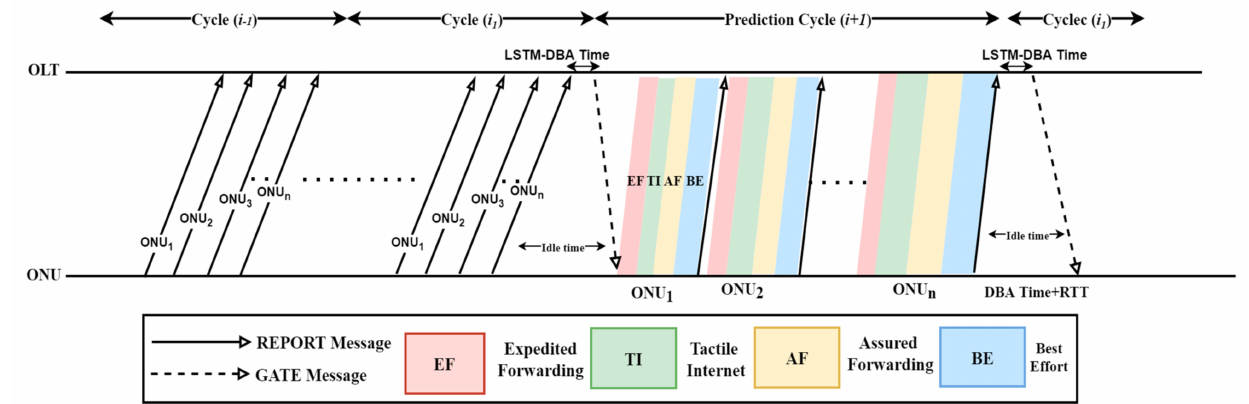
Figure 5. Prediction LSTM-DWBA upstream scheduling